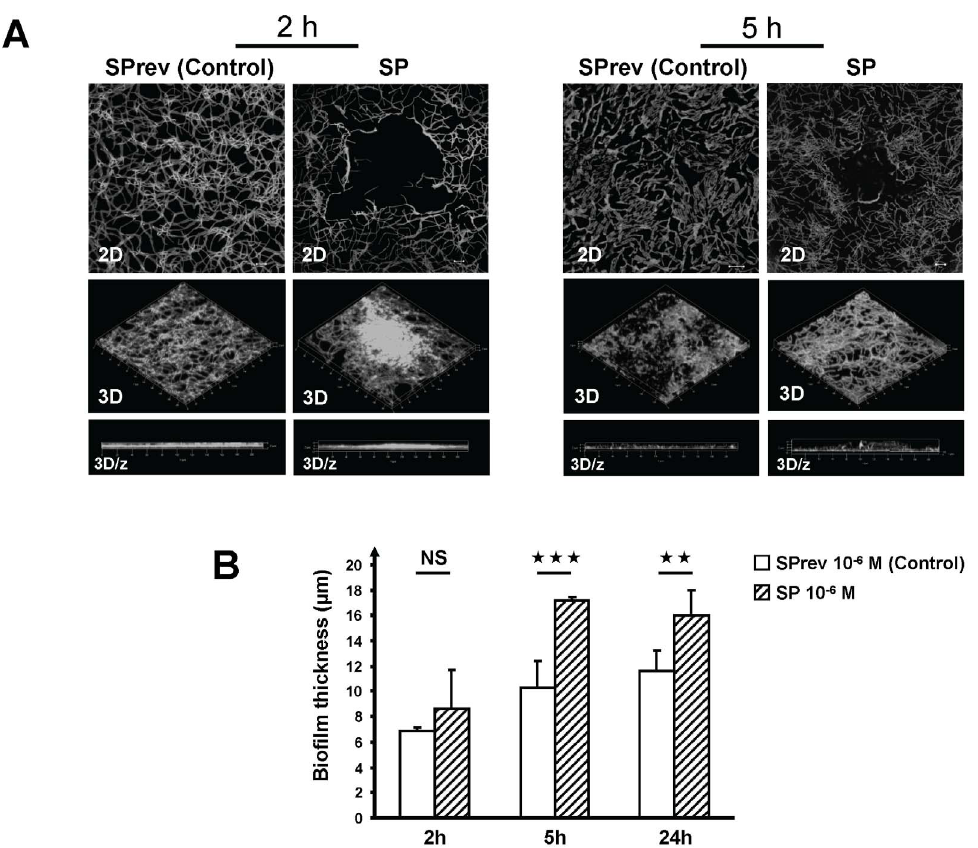
Figure 7. Effect of Substance P reverse (SPrev) and Substance P (SP) (10 2 6 M) on the biofilm formation activity of Bacilluscereus . The biofilm formation was observed after 2, 5 and 24 h. (A) Two dimensions (2D) and reconstructed three-dimensions (3D) and ortho cuts (3D/z) images showed that the density of the biofilm was essentially unchanged. (B) In contrast, the thickness of the biofilm was significantly increased after 5 and 24 h inclubation with SP (NS= non significant ; ww = p , 0.01 ; www = p , 0.001 ).